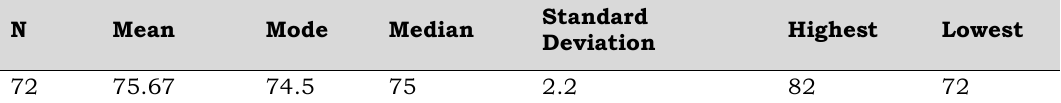
Table 1. The scores of students' writing taught using MALL